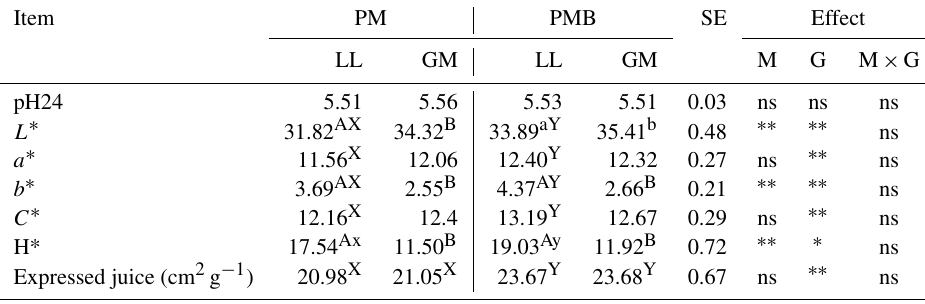
Table 2. The mean values of meat quality properties for different genotypes and muscles. Item PM PMB SE Effect LL GM